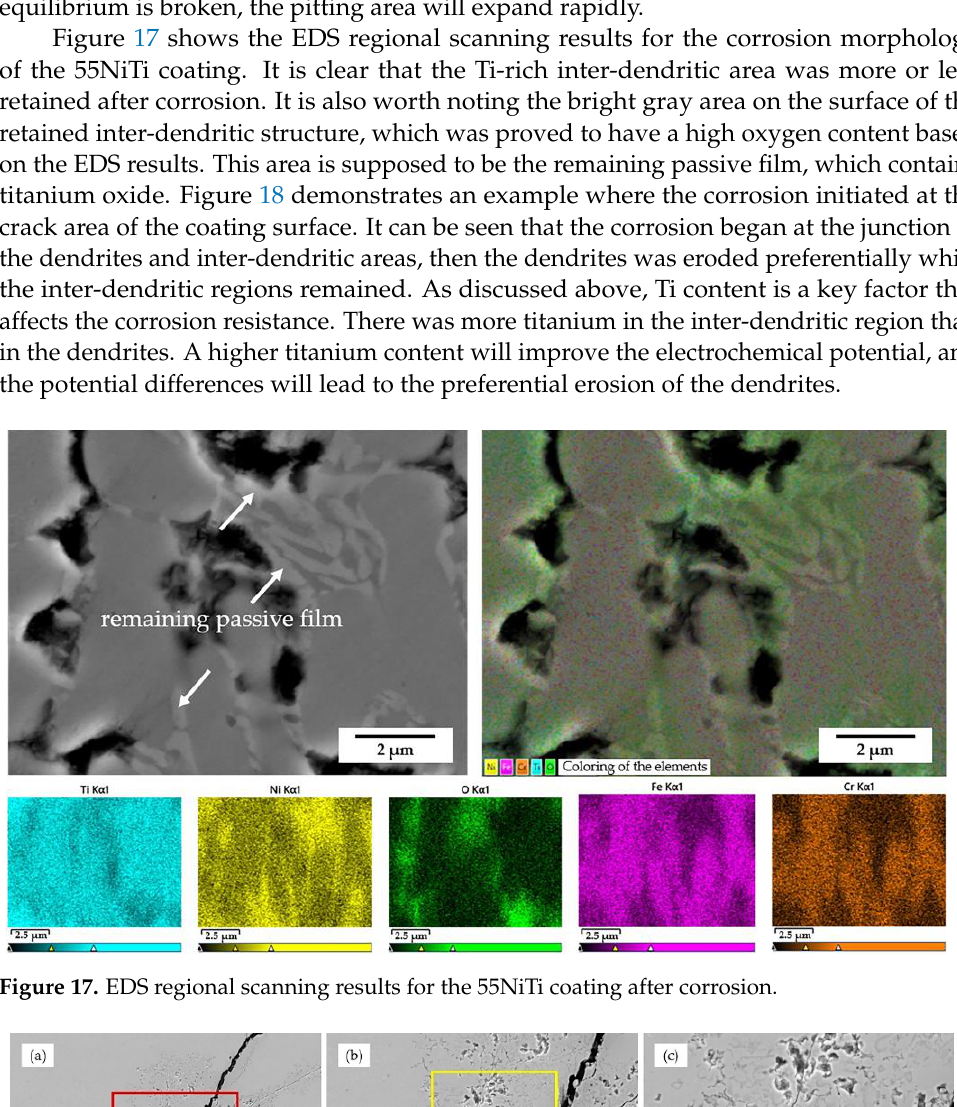
Figure 19. Schematic illustration of the corrosion expansion process. 4.3. The Impact of Immersion Duration on Corrosion Resistance of the Coating The samples were immersed in a 3.5 wt.% NaCl solution for 2, 5, and 10 h to study the effect of immersion duration on the coating corrosion resistance. Figure 20a exhibits the potentiodynamic polarization results of the coatings; the corrosion potential became